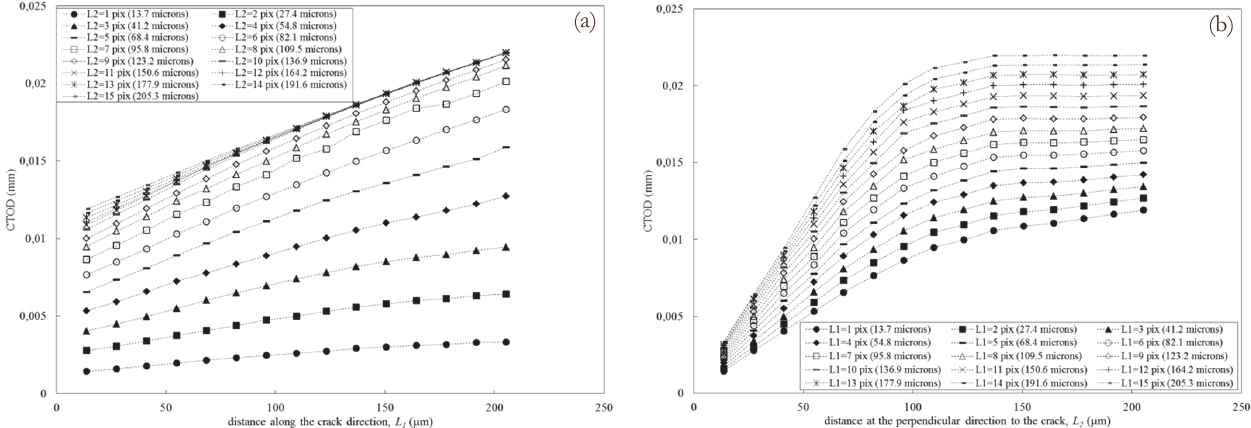
Figure 5: Graphs showing the effect of the location of the measurement point. (a) CTOD as a function of the distance along the crack direction L 1 ; (b) CTOD as a function of the distance at the perpendicular direction L 2 to the